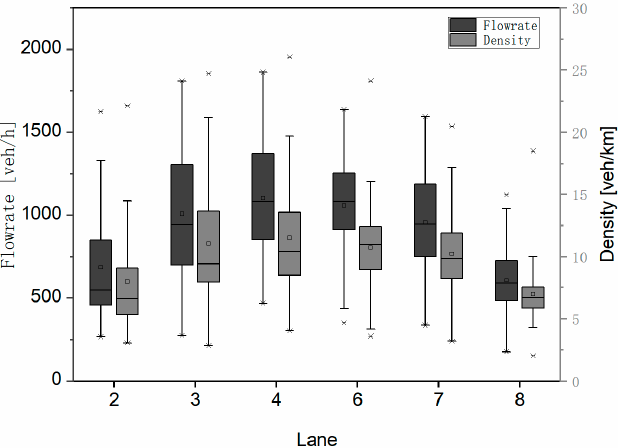
Figure 6. Flow rate and density in different lanes.